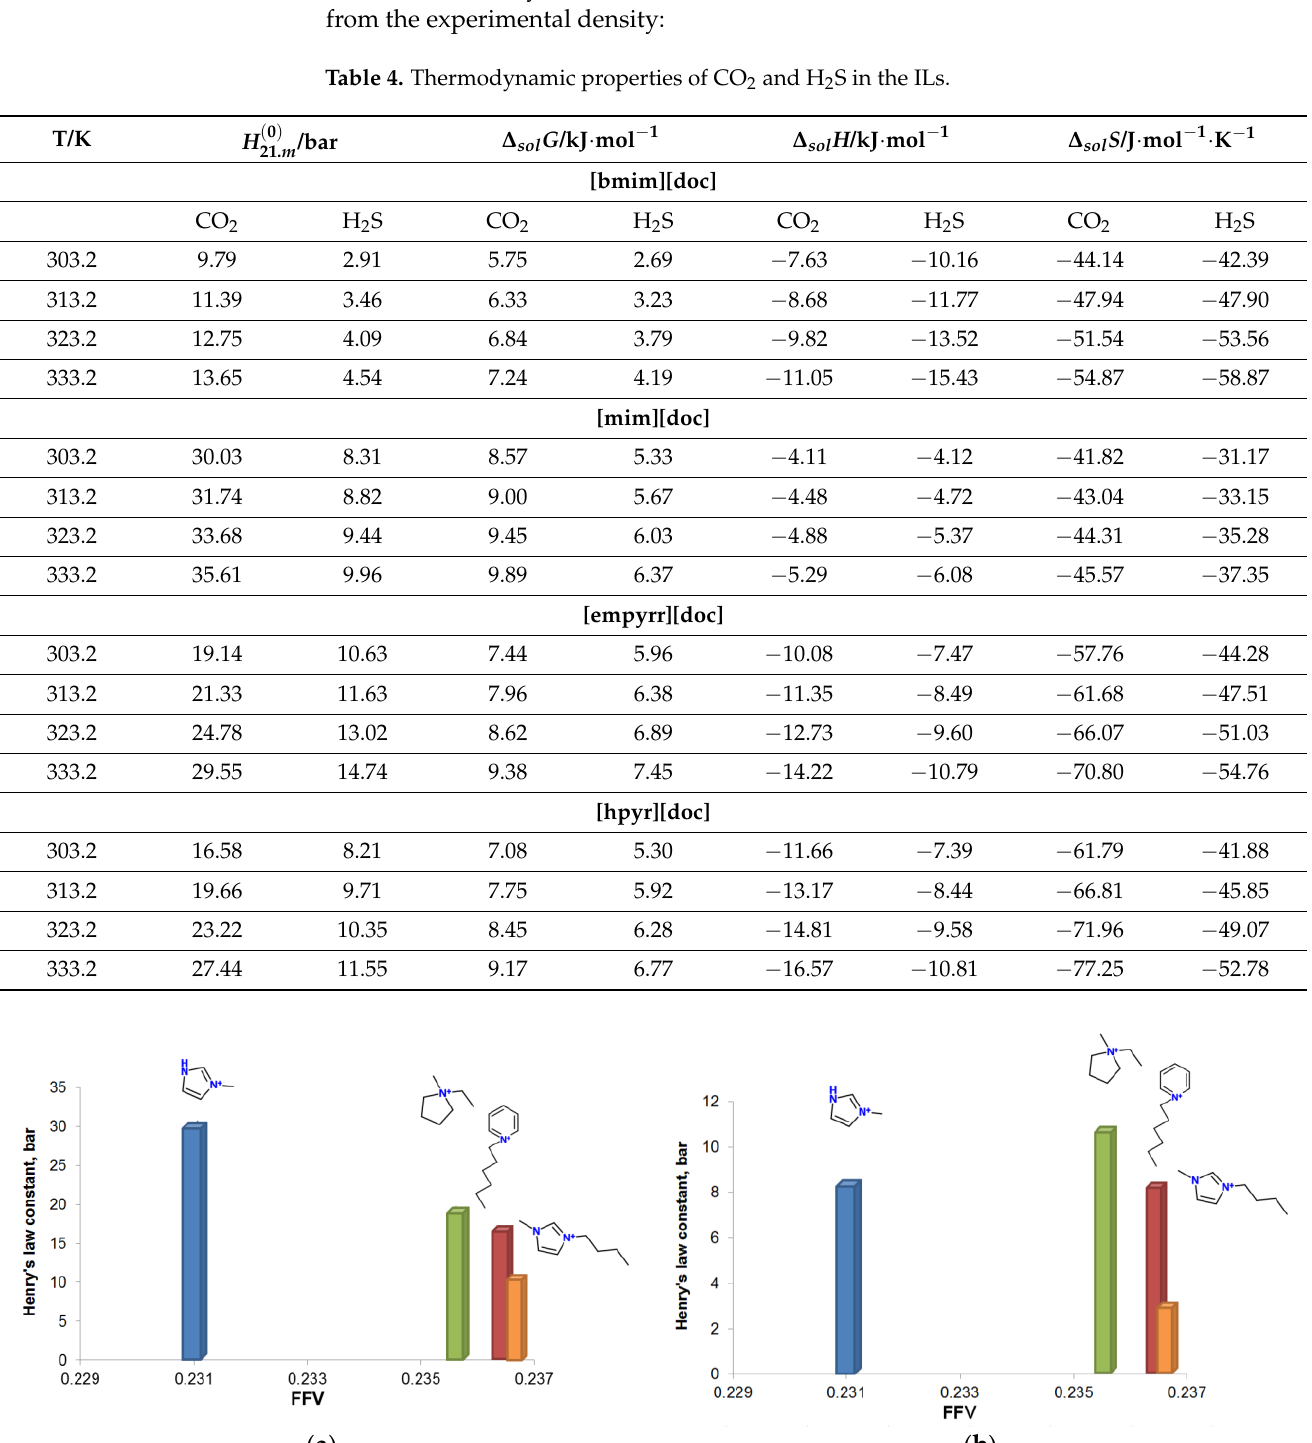
Table 4. Thermodynamic properties of CO 2 and H 2 S in the ILs.